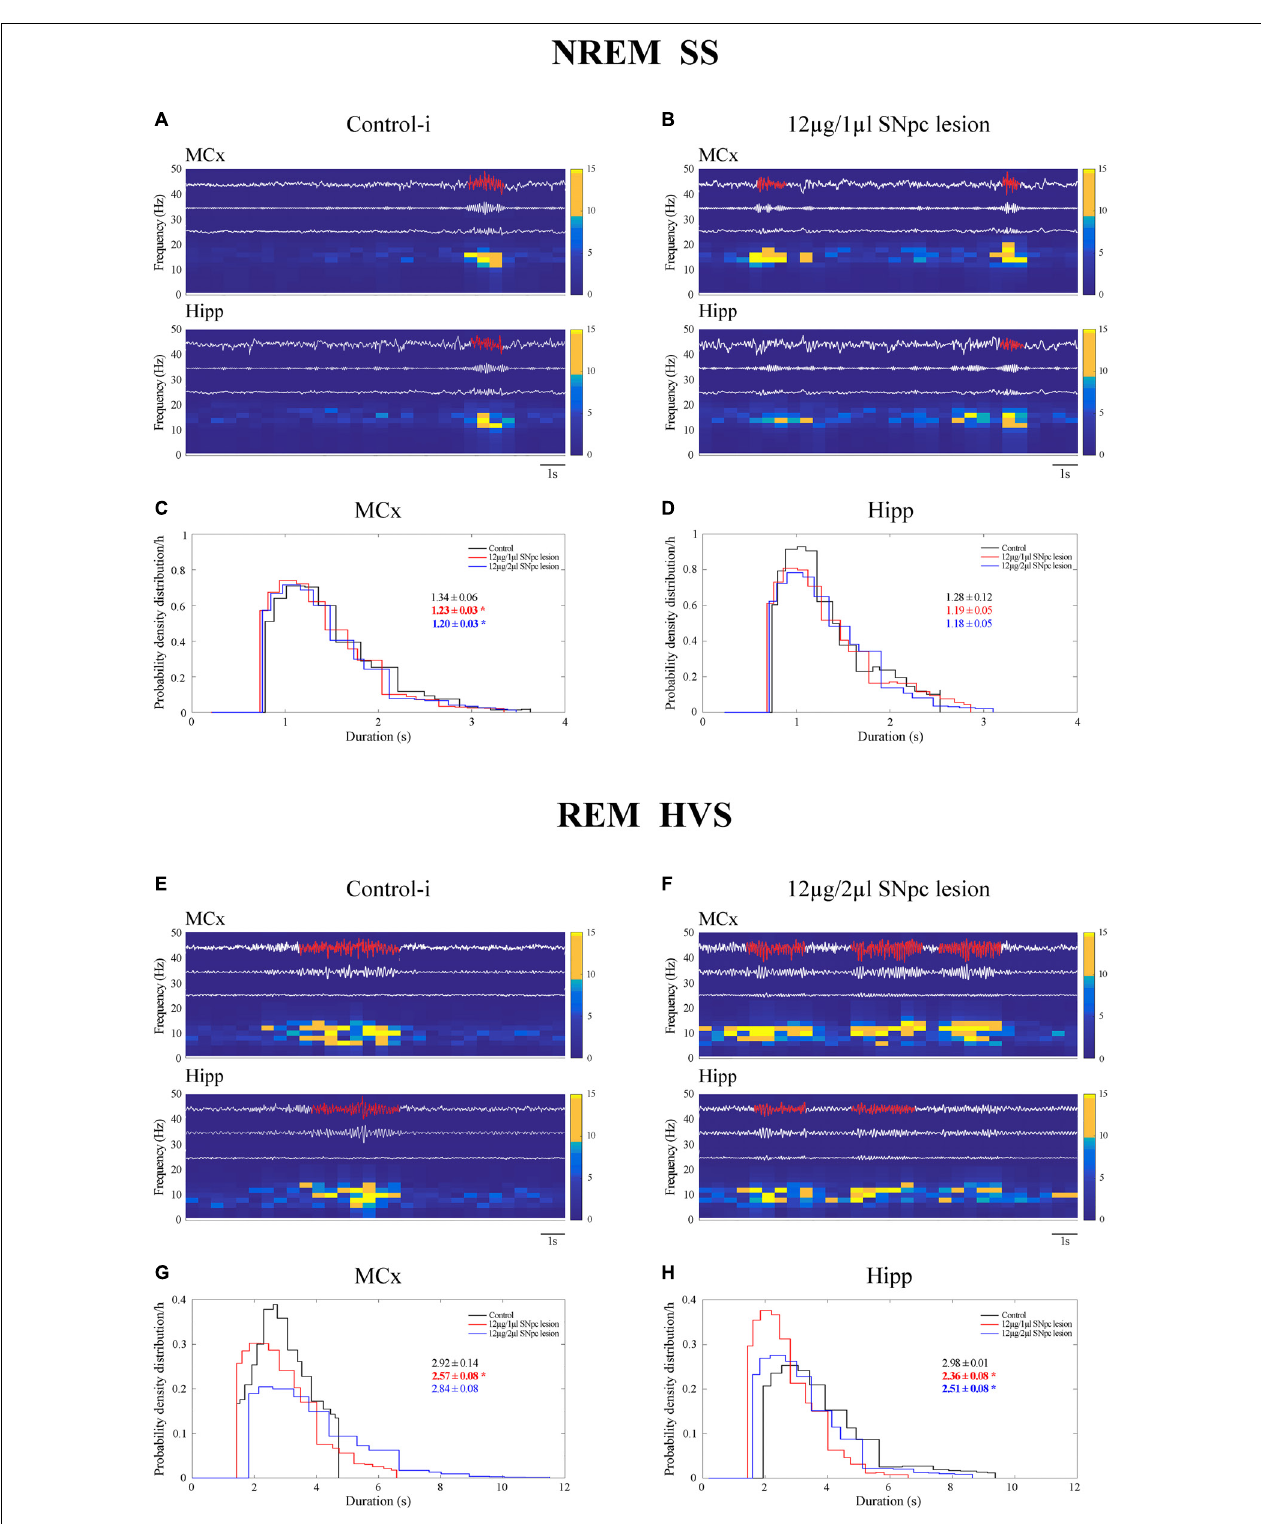
FIGURE 5 | Impact of the unilateral SNpc lesion on the sleep spindles (SS) and high voltage sleep spindles (HVS) dynamics during NREM and REM sleep. Individual examples of SS and HVS during simultaneous NREM and REM sleep in the MCx and hippocampus (Hipp) in the control (A,E) , and the SNpc lesioned rats (B,F) with their characteristic band pass filters used for their detection and extraction from the EEG signal (11–17 Hz band pass filter for SS; 4.1–10 Hz band pass filter for HVS), the corresponding EMGs and spectrograms, and the impact of the unilateral SNpc lesion on SS (C,D) and HVS (G,H) durations.